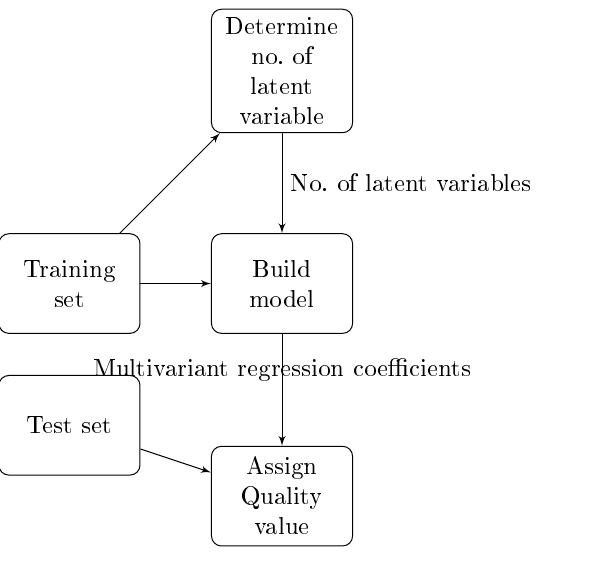
Figure 2. Learning machine (cid:29)owchart